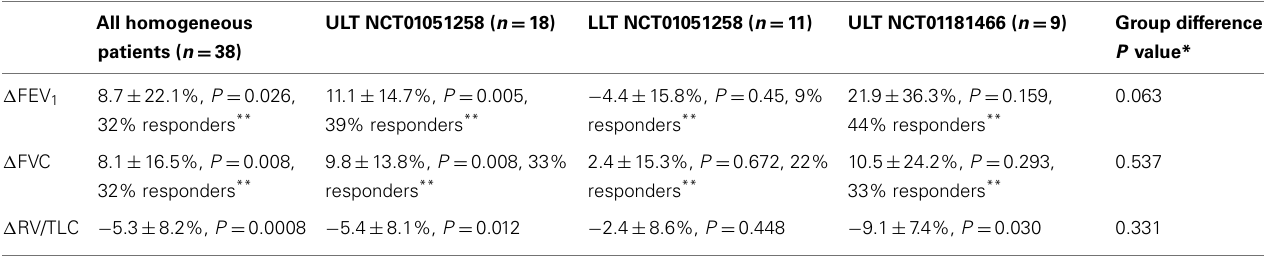
Table 3 | Summary of response to ELS therapy at week